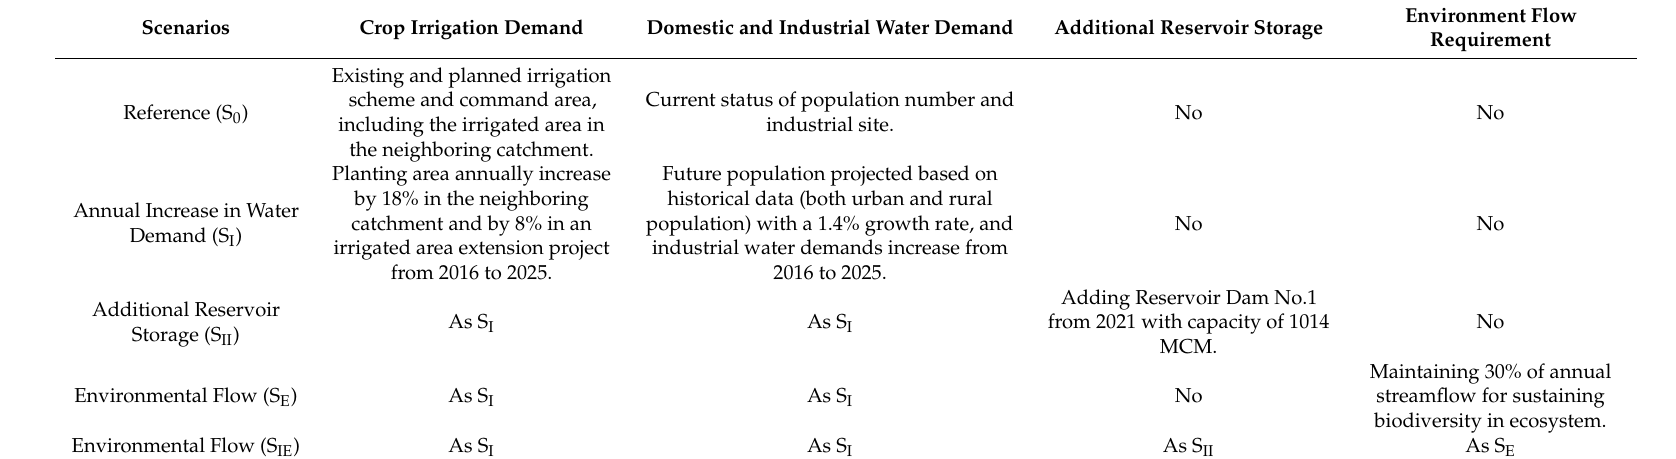
Table 5. Water management scenario descriptions.